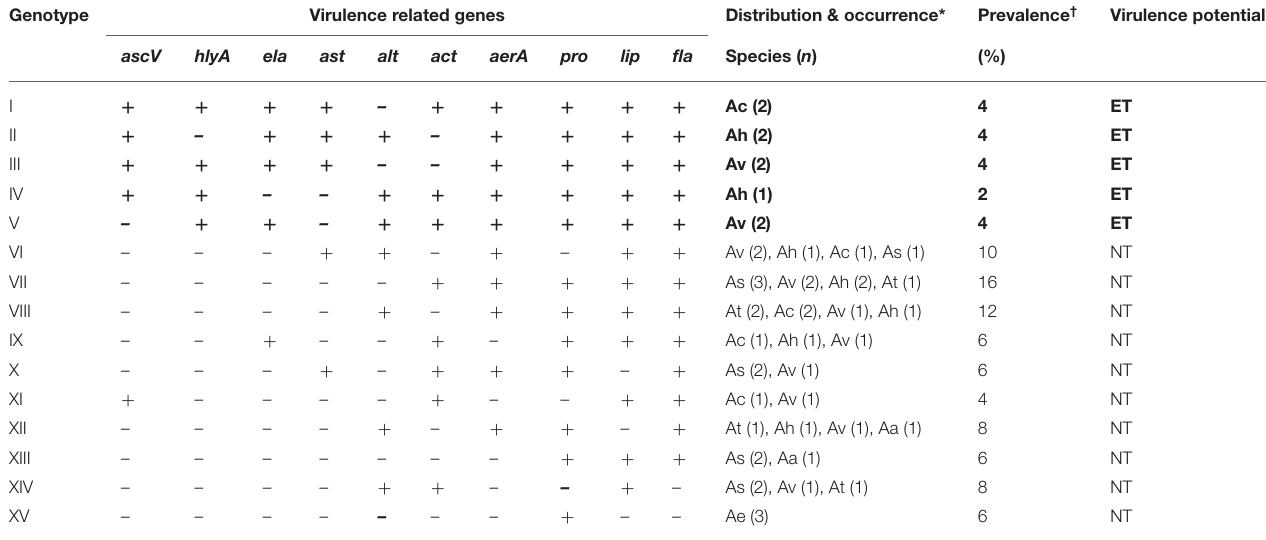
TABLE 3 | Distribution, prevalence, and virulence potential of the genotypes detected in Aeromonas strains isolated from coastal ponds in Bangladesh. Genotype Virulence related